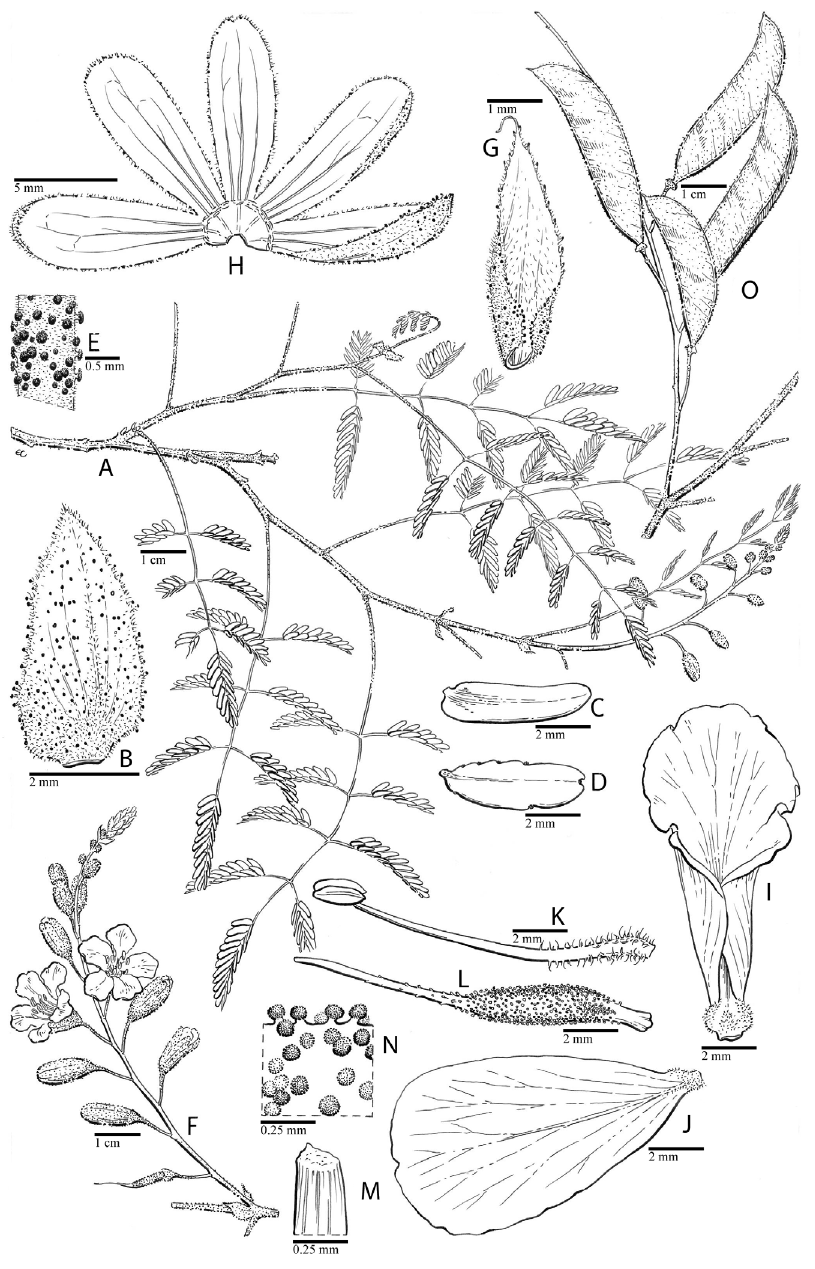
Figure 38. Arquita mimosifolia (Griseb.) E. Gagnon, G. P. Lewis & C. E. Hughes. A flowering branch- let B stipule C eglandular leaflet undersurface D glandular leaflet undersurface E detail of glands on stem F inflorescence G bract H calyx opened out I median petal J lateral petal K stamen L gynoecium M stigma N detail of glands on ovary O fruits. A–E, G–N from Kiesling et al. 4990 F from Lorentz s.n. O from Schreiter 68526. Drawn by Eleanor